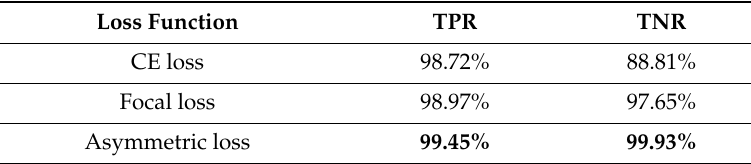
Table 8. Comparison of TPR / TNR of di ff erent loss